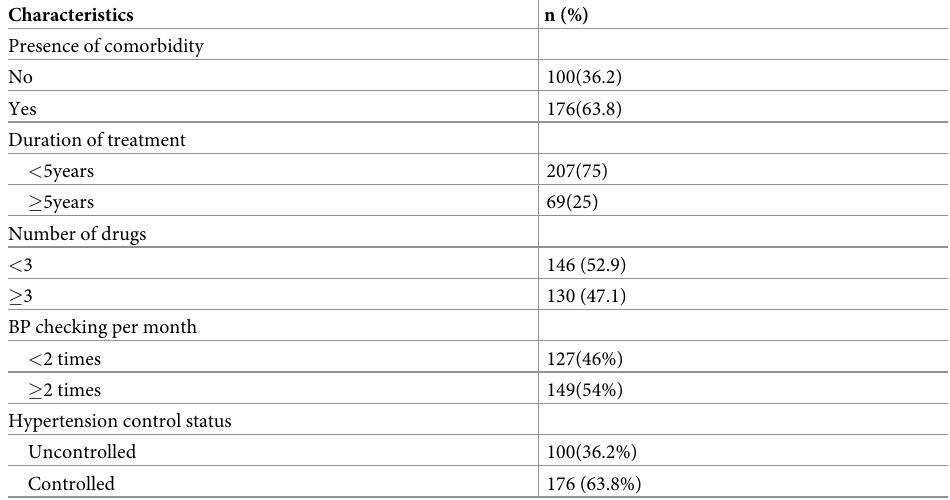
Table 3. Clinical and treatment related characteristics of hypertensive patients in ACSH, 2017 (n = 276). Characteristics